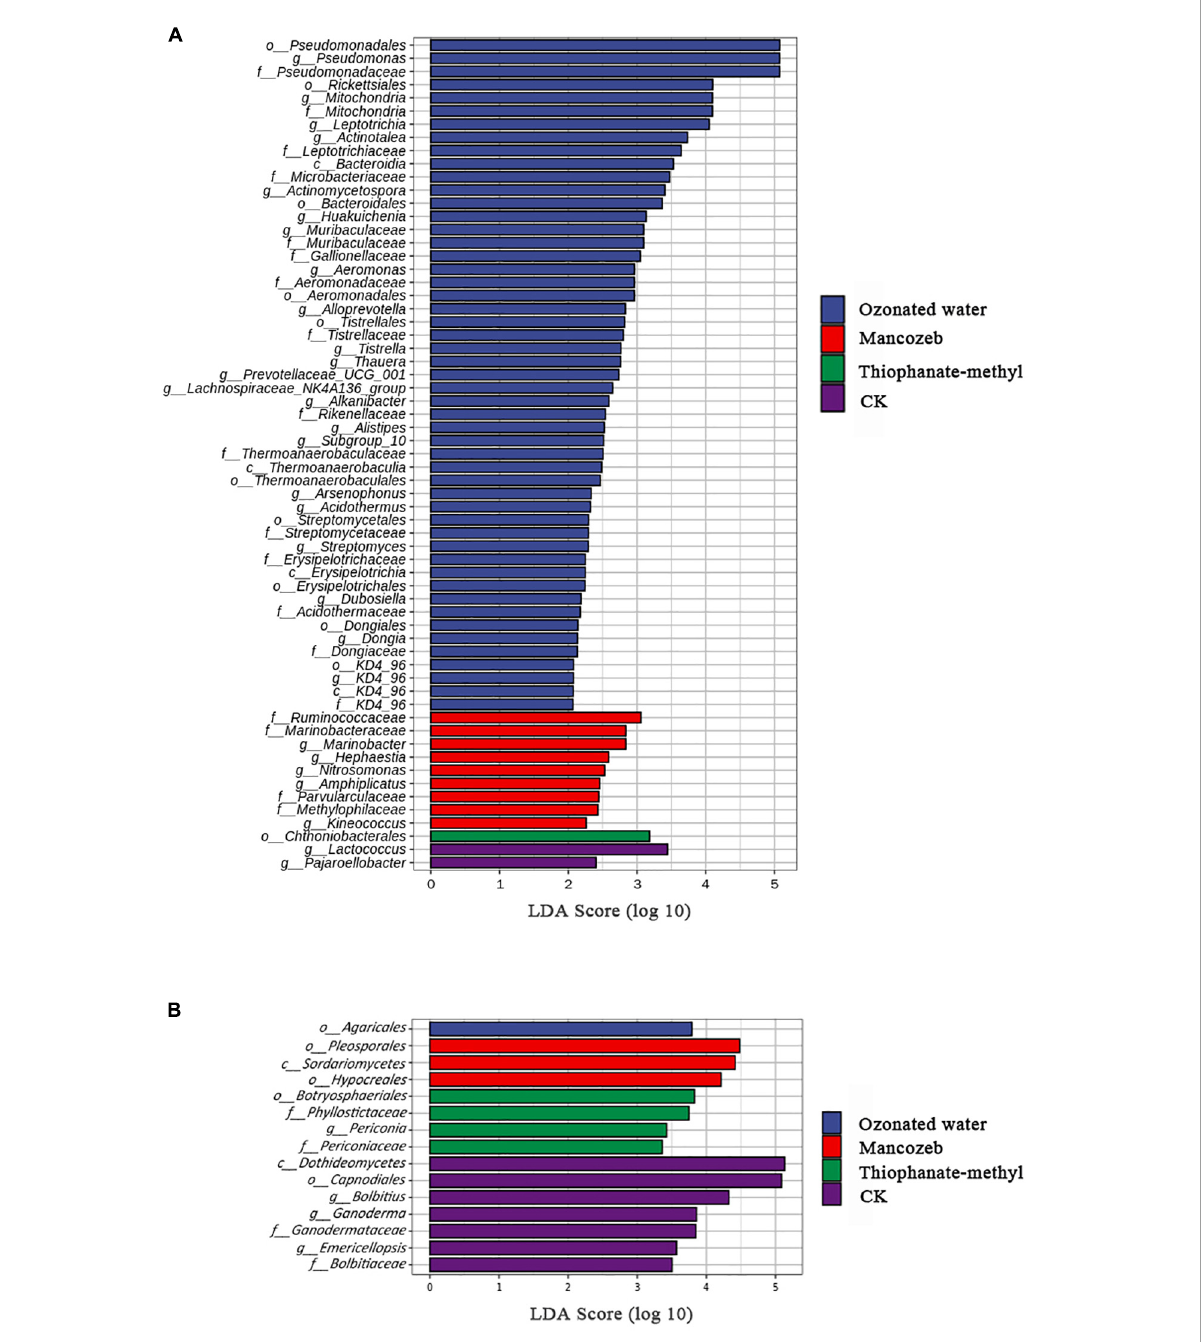
FIGURE4 Linear discriminant analysis effect size (LEfSe) analysis of phyllosphere microorganisms of different treatments: (A) bacteria and (B) fungi.